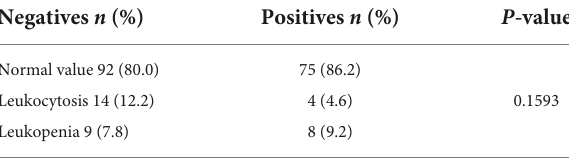
TABLE 5 Frequency analysis of lymphocyte count in the study population.